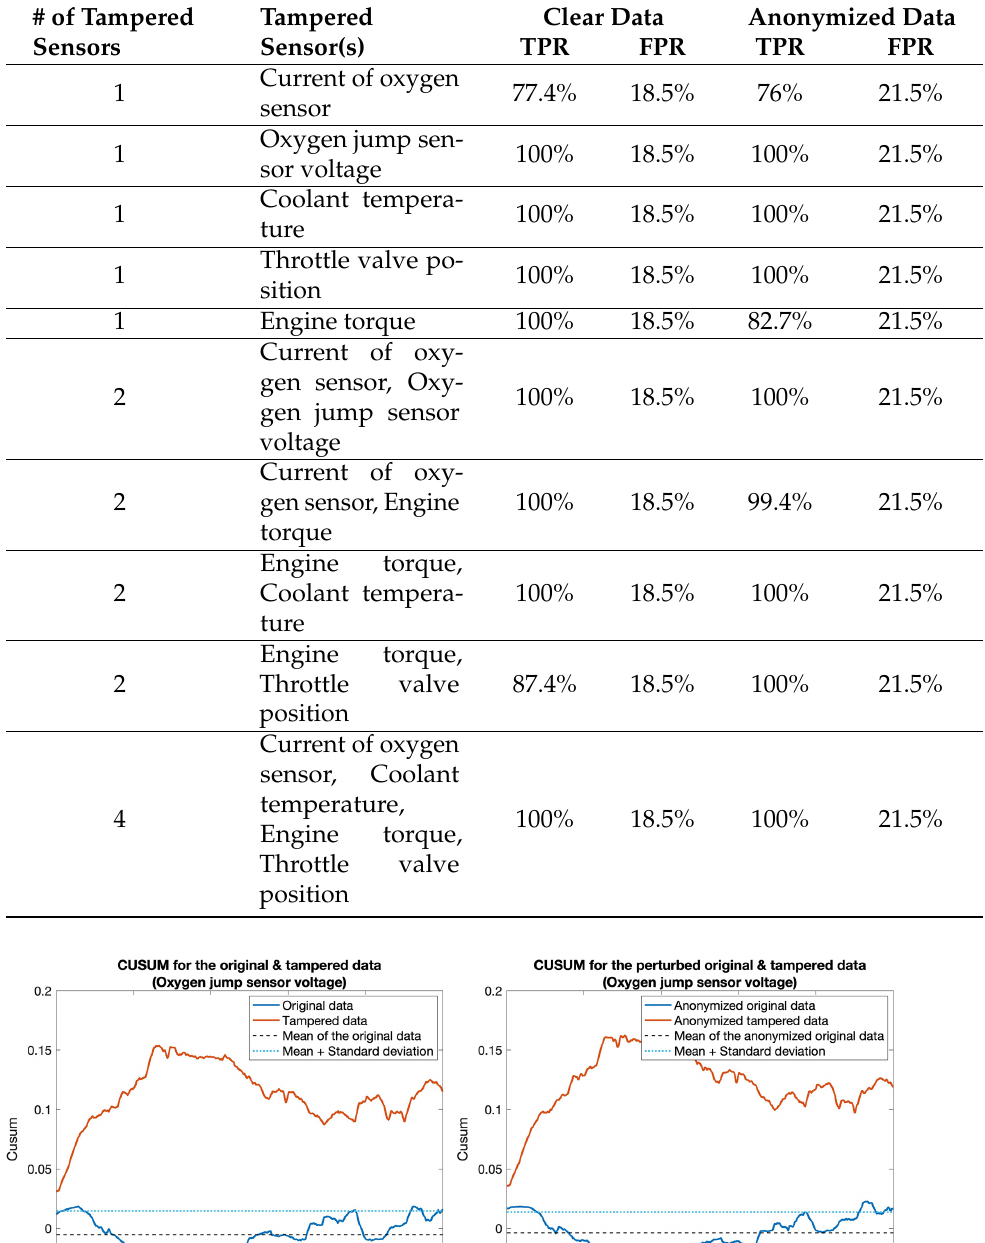
Table 3. TPR and FPR for the described tampering detection process.